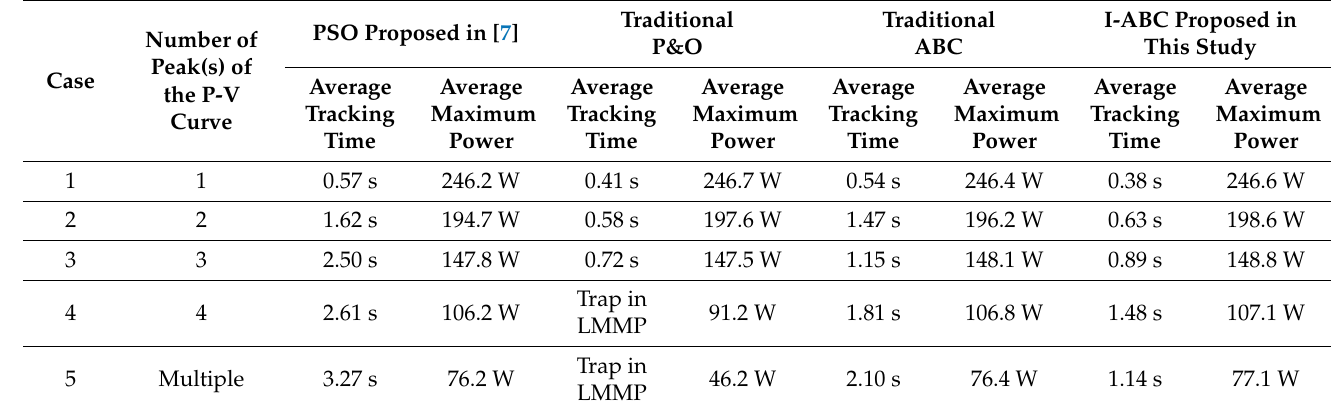
Table 6. Comparison of experimental results for the five selected